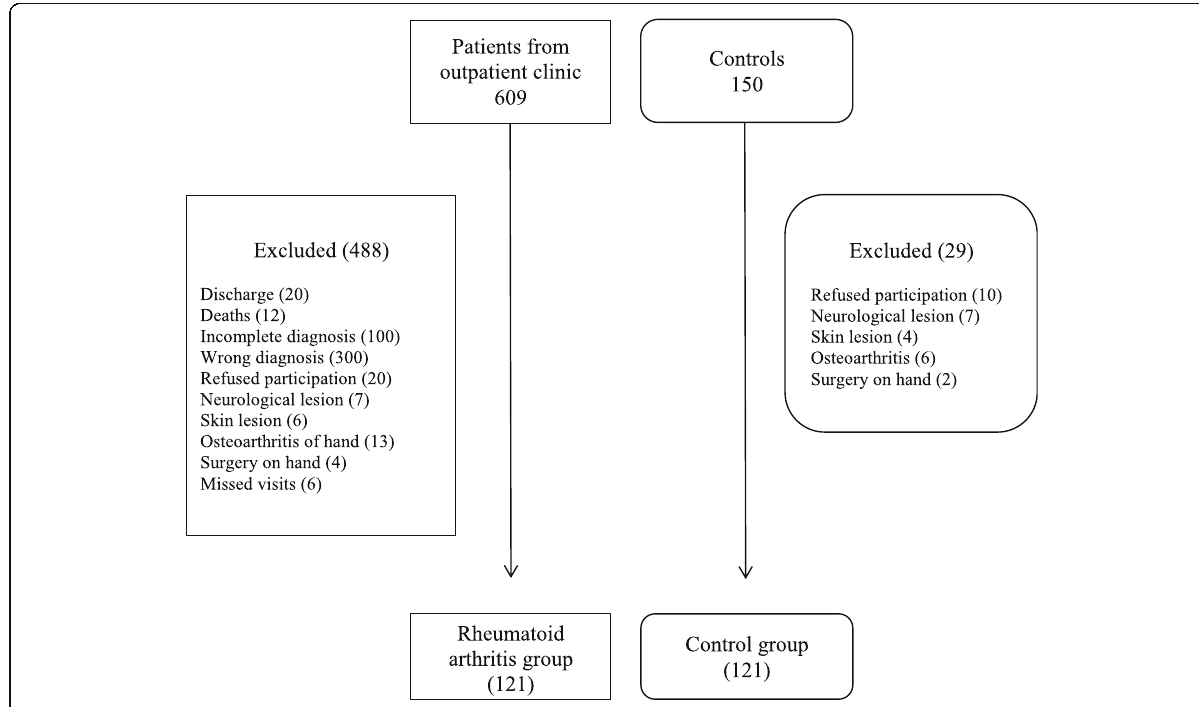
Fig. 1 Flowchart representing the steps for participant